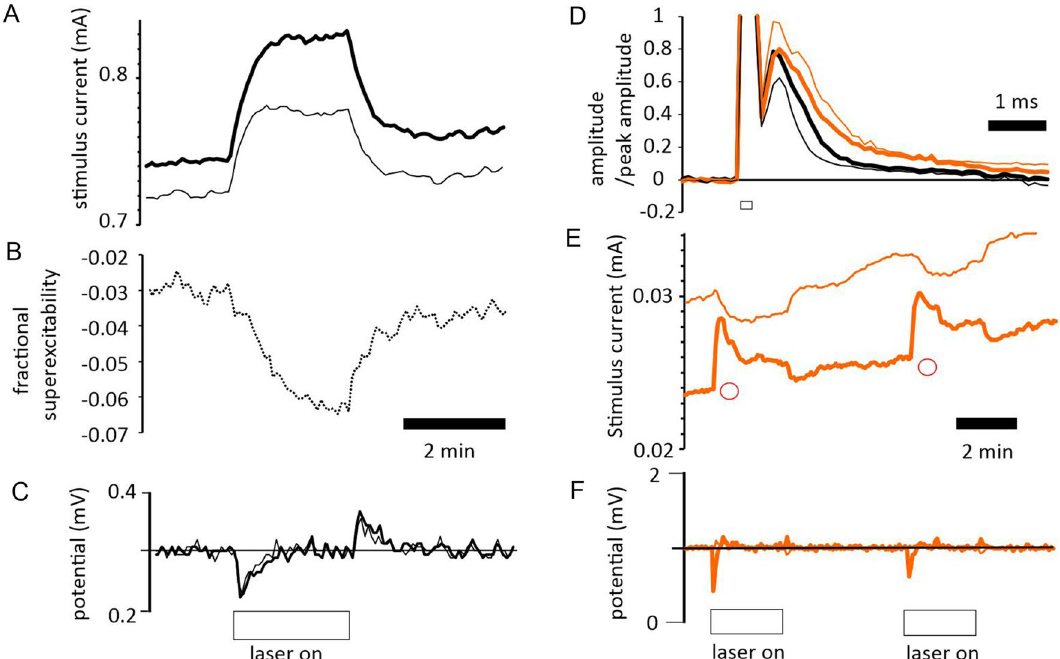
Figure 2. Application of IR laser light to a nerve at the site of stimulation, while threshold-tracking. ( A ) laser light application (indicated in panel ( C ), driving laser using 350 mA) gives rise to an increase in threshold when maintaining a 50% supramaximal response. Control threshold (bold trace), and threshold at 10 ms following a conditioning stimulus (fine trace) undergo increases. ( B ) The fractional difference between the control and conditioned threshold reveals increased superexcitability during the application of laser light. ( C ) The stimulus current used to generate the control (bold trace) and conditioned (fine trace) responses is unable to maintain response amplitude as soon as the light is activated, but over the course of 2 min increases enough to overcome the inhibition. When the light is removed, the threshold-tracking program brings the response amplitude down by reducing the stimulus current. ( D ) F-fibre response at 5% of supramaximal amplitude (black trace; mean, n = 4) is modified by exposure to 200 µM 4-AP (orange trace; mean, n = 4), with the action potential widening (at 0.5 amplitude, P = 0.02, paired t-test) and the depolarizing afterpotential (DAP) increasing in amplitude and duration. Application of stimulus current indicated as open bar, and means with − 1 sem (control) or + 1 sem (4-AP) are plotted; sems plotted as fine lines. Data collected in the presence of 4-AP plotted in orange. ( E ) Laser light application (using 400 mA driving current, ie 600 mJ per minute) indicated underneath panel ( F ), produces an immediate fall in the amplitude of the F-fibre response (see bold trace in ( F ) below), which is then compensated-for by a rise in the applied current, maintaining the target response amplitude. A rapid rise in threshold results, indicated by red circles, that is not fully maintained. The conditioned response threshold at 4 ms following a previous stimulus is a measure of refractoriness, and is plotted as a fine trace. Refractoriness falls during laser light application. ( F ) Changes in peak response amplitude during threshold-tracking, before, during and after laser light application. Bold and fine traces are responses to test and conditioned stimuli,